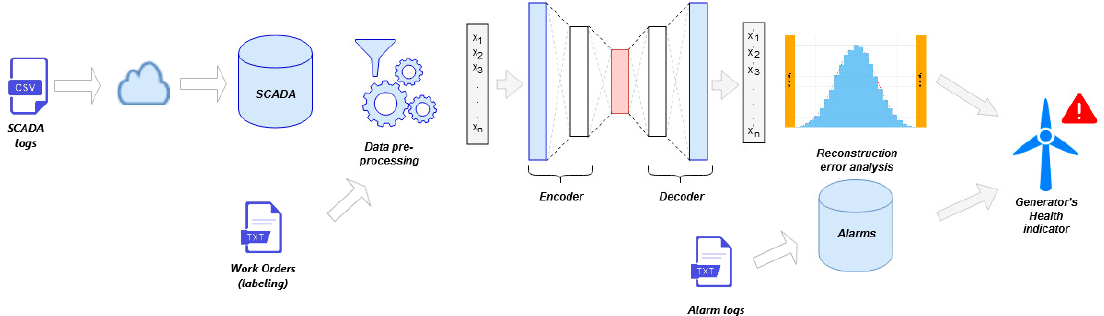
Figure 1. Alarm and autoencoder hybrid predictive system pipeline.